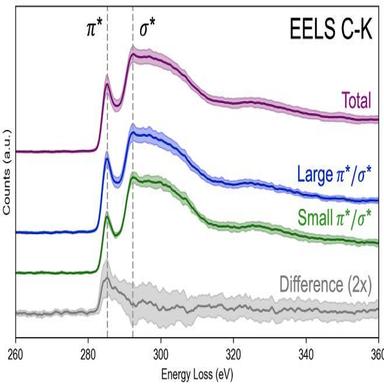
Statistical analysis of local C bonding environment at Re sites. The mean and standard deviation of C K-edges acquired at >50 Re sites is plotted in magenta. Spectra were filtered by their π/σ integrated intensity ratio, and the mean and standard deviation of those with "large" and "small" ratios are plotted as blue and green, respectively. The difference in these spectra is plotted in gray, showing that the difference in ratio arises mainly from the intensity of the π peak, with no statistically significan